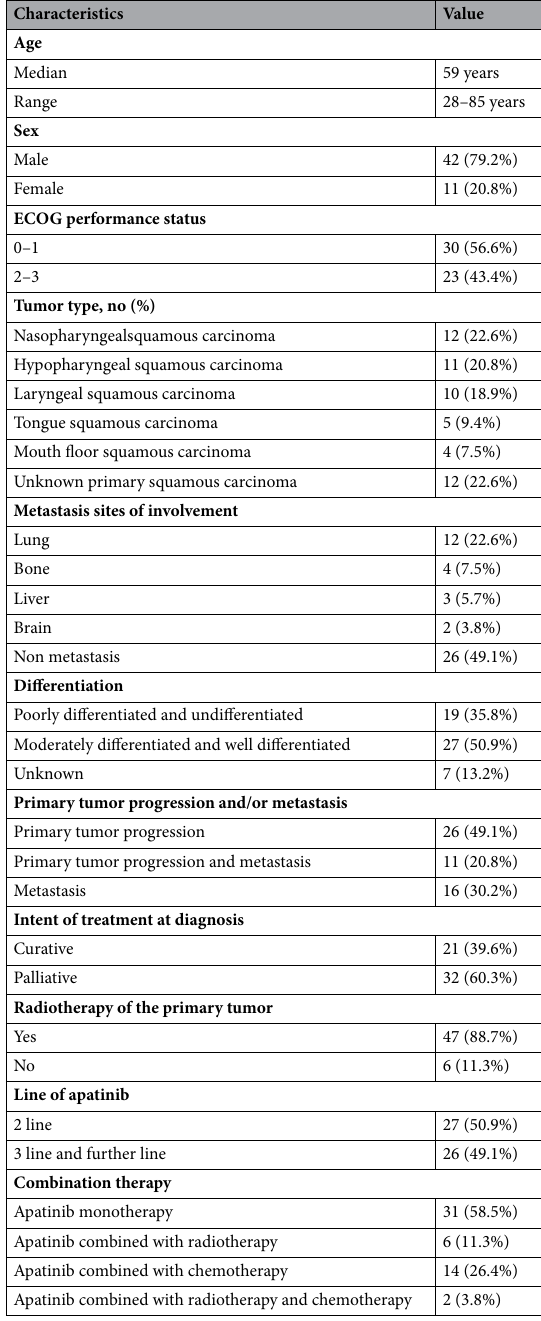
Table 1. Clinical and treatment characteristics of 54 recurrent metastatic head and neck squamous cell carcinom patients who received apatinib. ECOG Eastern Cooperative Oncology